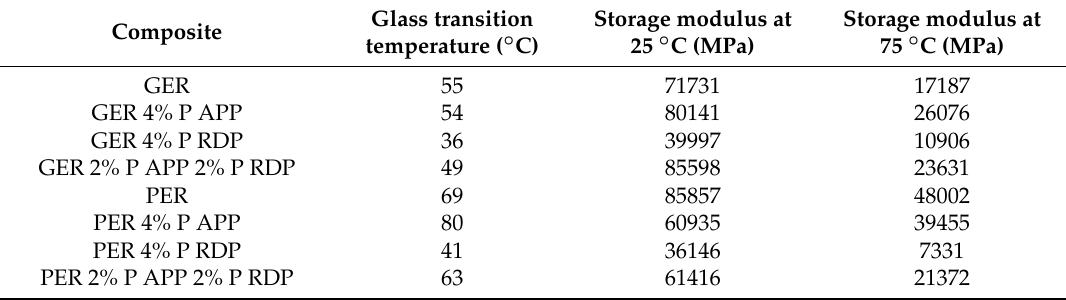
Table 8. The glass transition temperature and storage modulus of the reference and flame retarded composites.